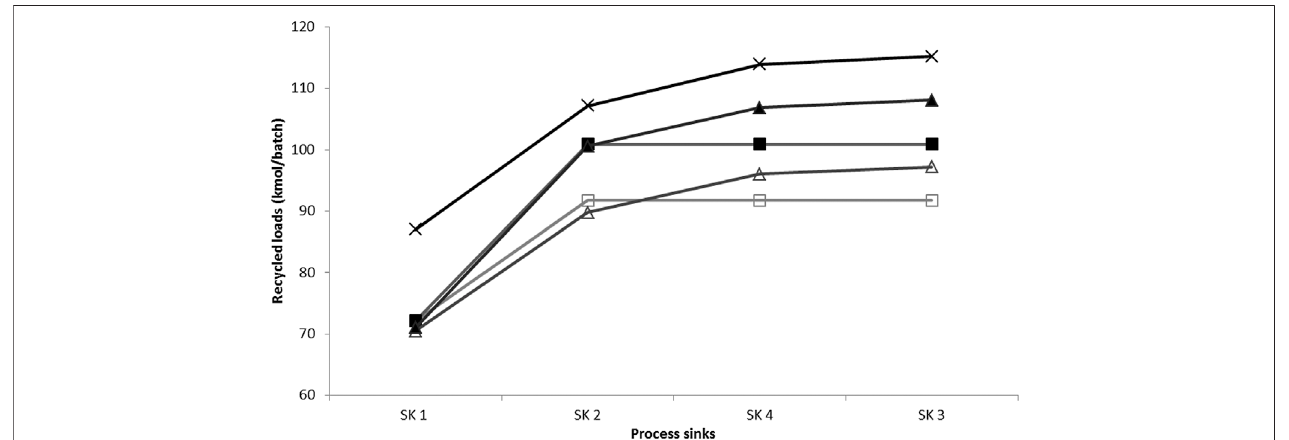
FIGURE 5 | Cumulative curve of the optimal recycled loads in the case study-1 (SMI NPM : crosses; SMI RPM at b (cid:1) 0% for single-variable sequential optimization at each process selection step: hollow squares; SMI RPM at b (cid:1) 0% for multi-variable simultaneous optimization at each process selection step: full squares; SMI RPM at optimal b (cid:1) 3% for single-variable sequential optimization at each process selection step: hollow triangles; SMI RPM at optimal b (cid:1) 2% for multi-variable simultaneous optimization at each process selection step: full triangles).